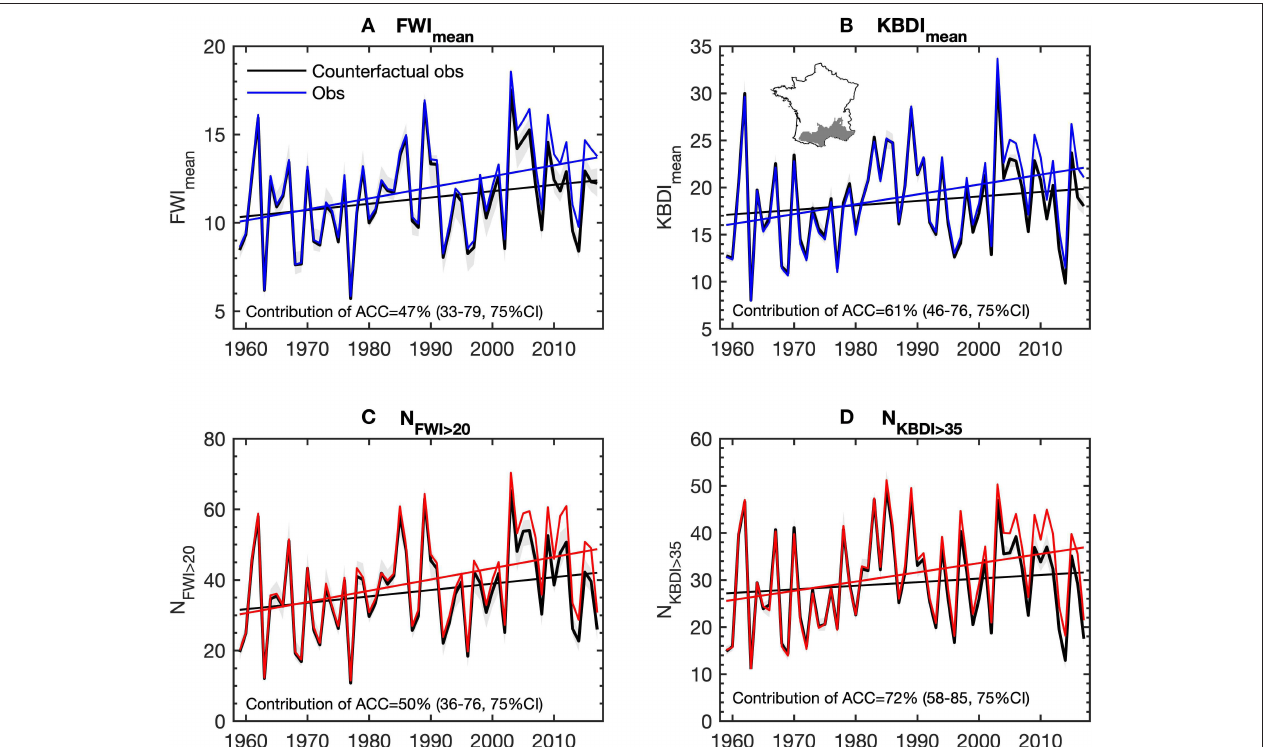
FIGURE 3 | (A) Mean FWI from May to September averaged across the Mediterranean region (see map) using observations (color) and counterfactual observations (black) as deduced from the multimodel mean. The shaded gray area shows the 75% range of counterfactual observations as deduced from different GCMs. Linear trends are also shown as well as the fractional contribution of anthropogenic climate change (ACC) calculated as 100 of the linear trend. The mean fractional contribution across models as well as the interquartile range are indicated. (B) Same as (A) but for KBDI. (C) Same as (A) but for N FWI > 20 . (D) Same as (A) but for N KBDI > 35